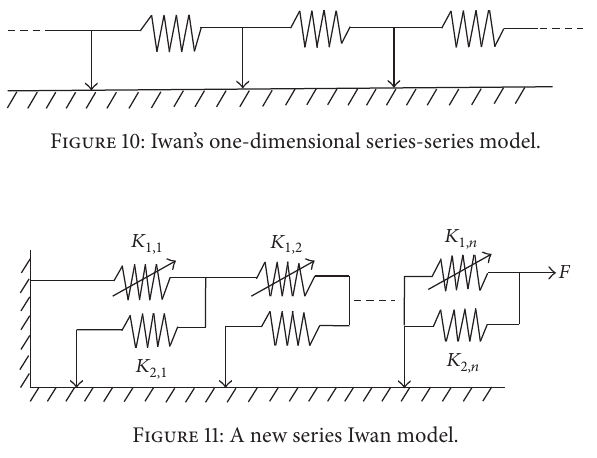
Figure 14: Comparison of frequency response functions for various bolt torque levels when the force amplitude 𝐹 exc = 100 N.